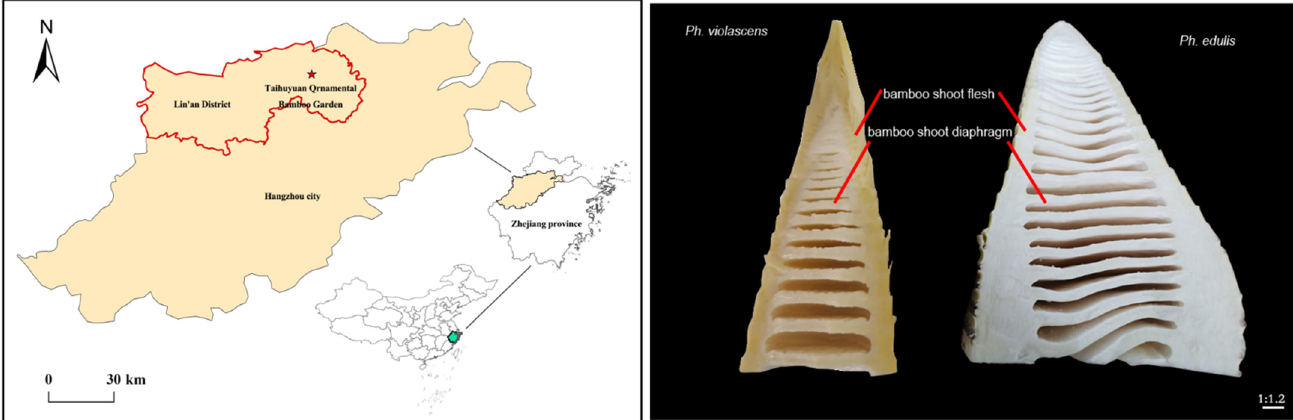
Figure 1. Geographic location of the Taihuyuan Ornamental Bamboo Garden in China ( left ) and a photograph showing the bamboo shoot diaphragm and flesh of Ph. edulis and Ph. violascens ( right ). The pentagram means the location of study site in the Taihuyuan Ornamental Bamboo Garden, Lin’an City, Zhejiang Province, China.